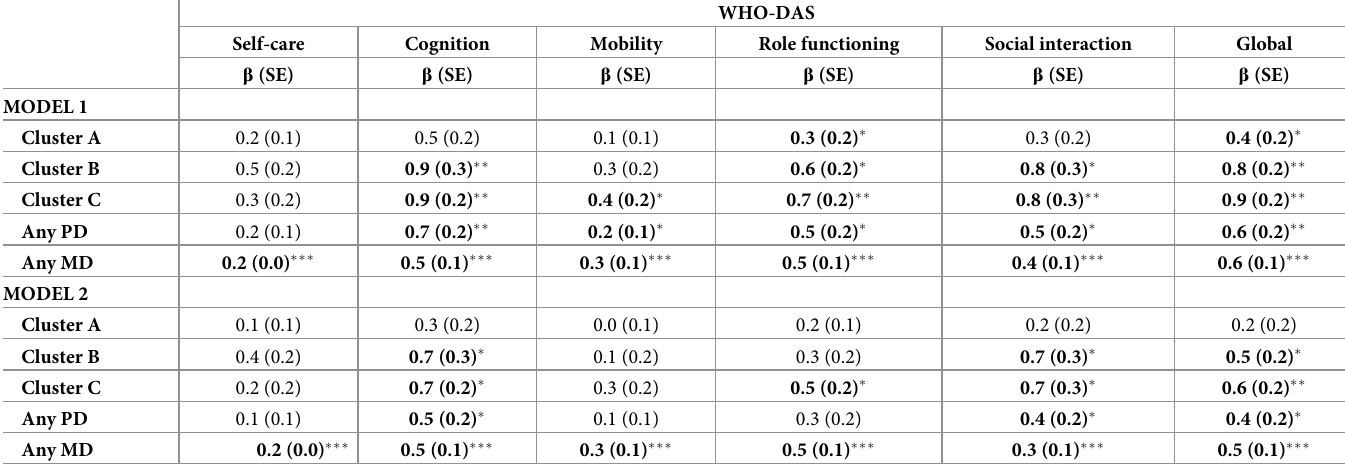
Table 6. Impairment associated with personality disorders in the Sao Paulo Metropolitan